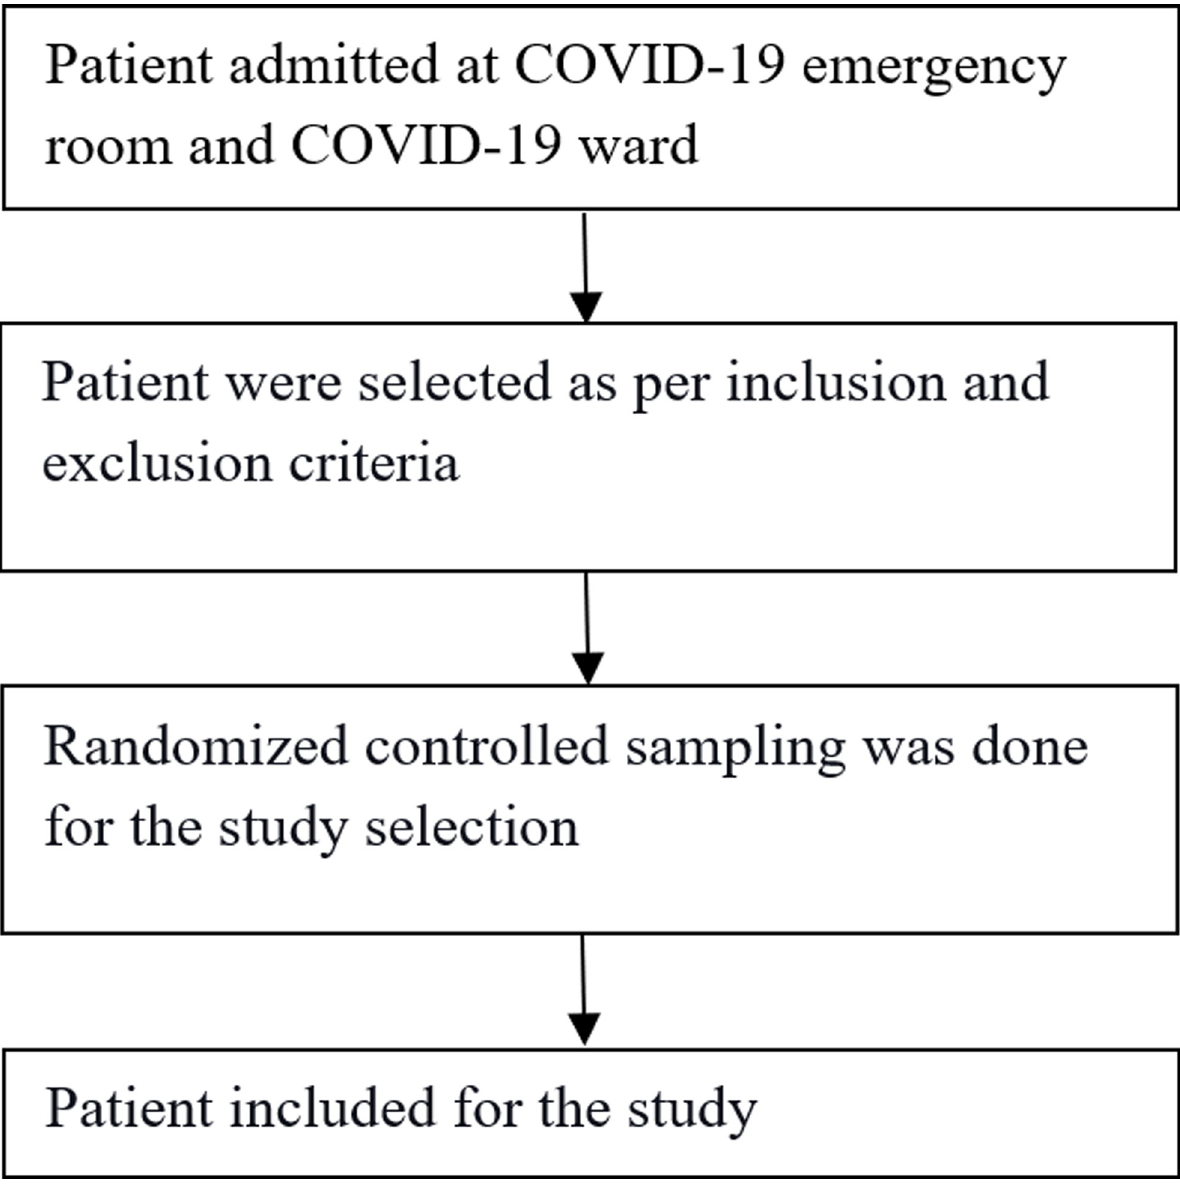
Fig 1. Study flowchart for selection of study